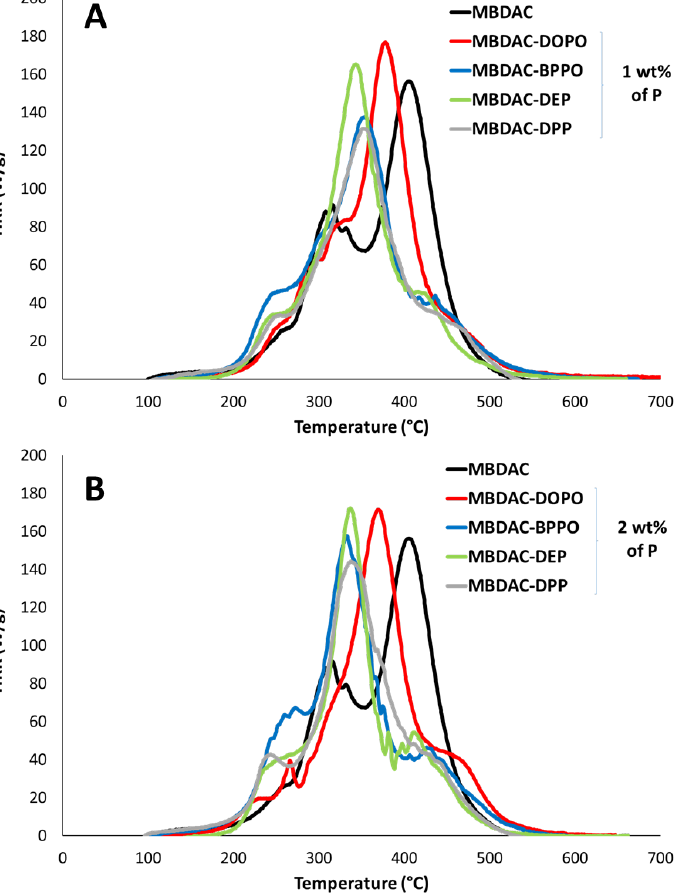
Figure 3. HRR curves for all PHUs in PCFC ( A ) with 1 wt% of phosphorus, ( B ) with 2 wt% of phos-